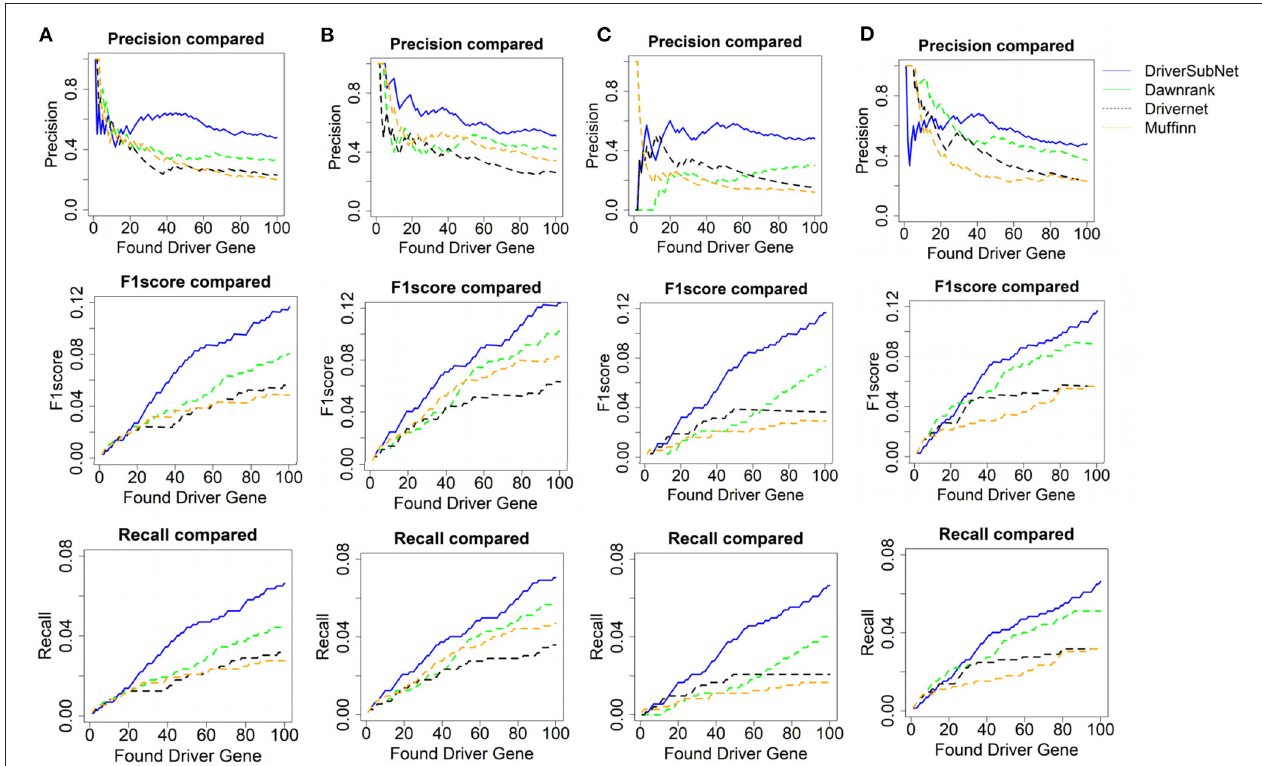
FIGURE 2 | Performance comparison with CGC in terms of precision, F 1 score, and recall of Dawnrank and DriverNet methods on (A) BRCA, (B) HNSC, (C) KIRC, and (D) THCA